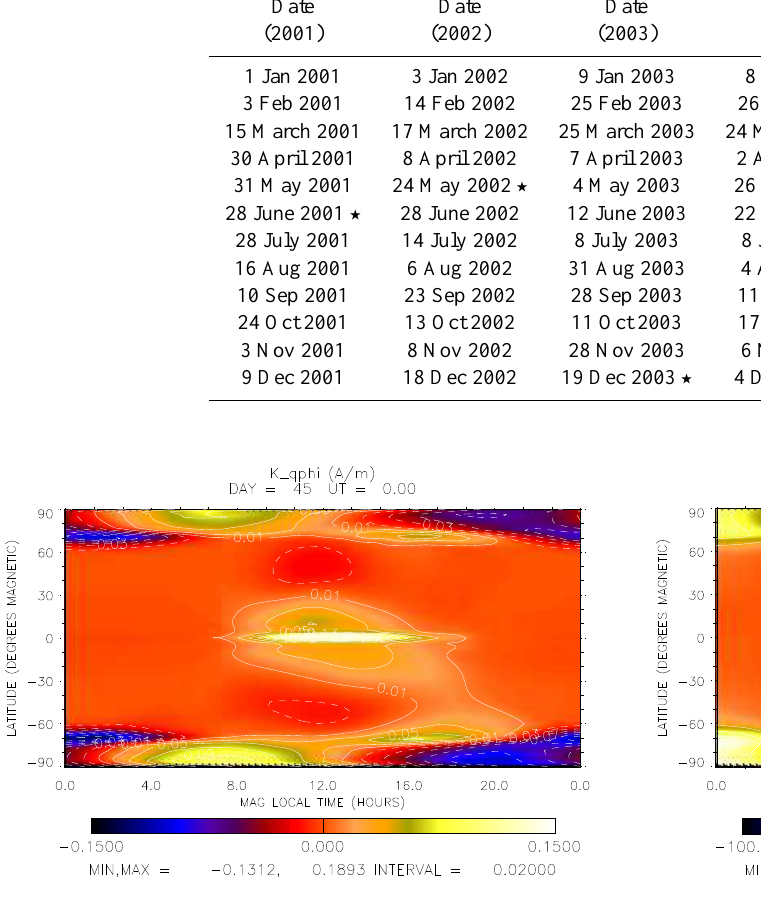
Fig. 2. The eastward component of the height-integrated horizontal current density in units of A / m predicted by the TIE-GCM for 14 February 2002 using GPI inputs.